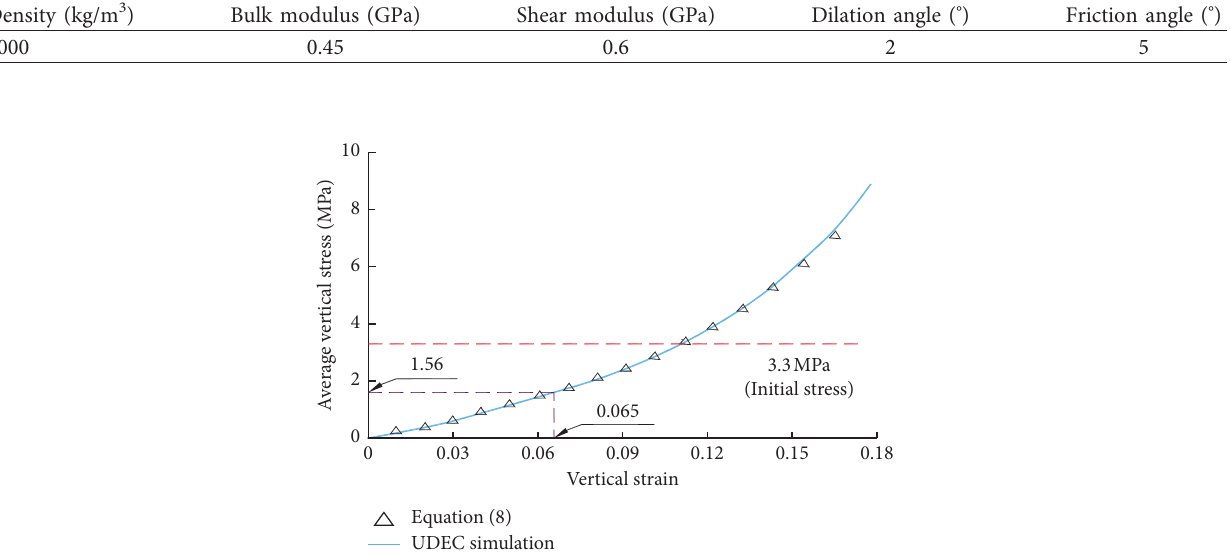
Figure 5: The UDEC results of compaction characteristics of the gob.